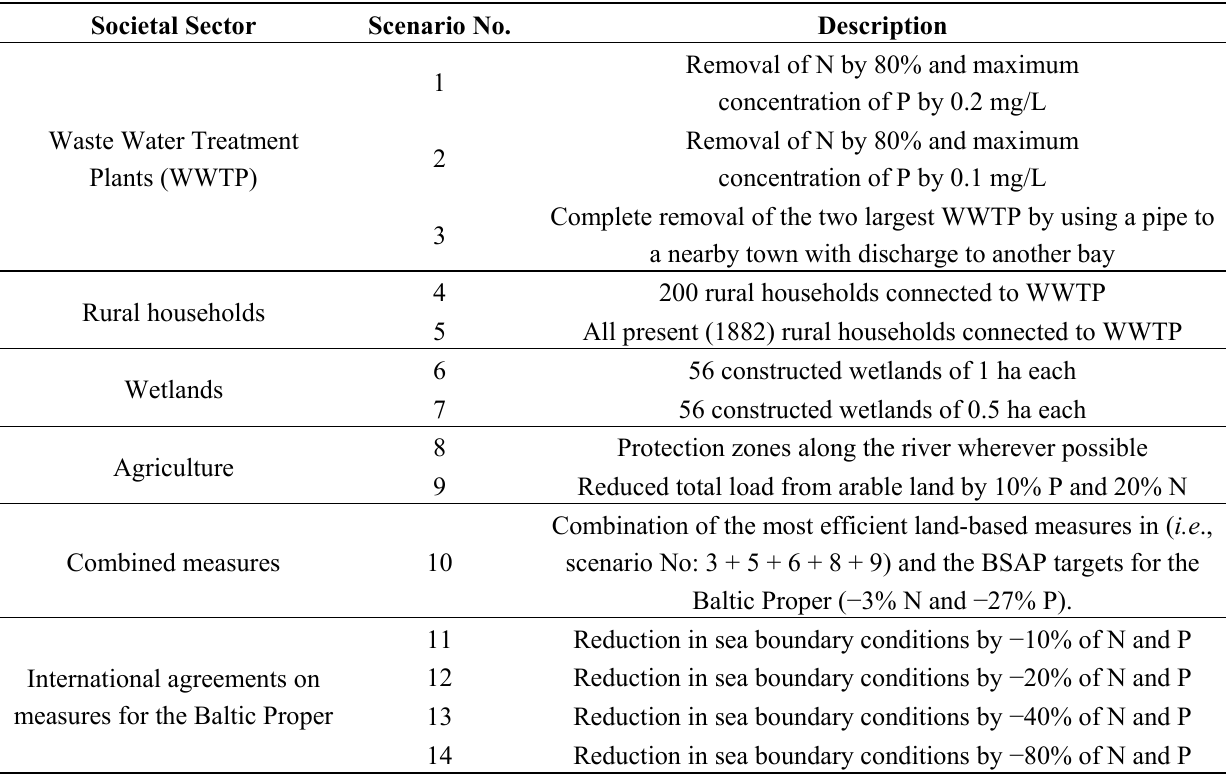
Table 1. Scenarios of reduced nutrient contribution from land-based sources and sea concentrations, respectively, which were used in the experiment on effects on water quality in the Skälderviken